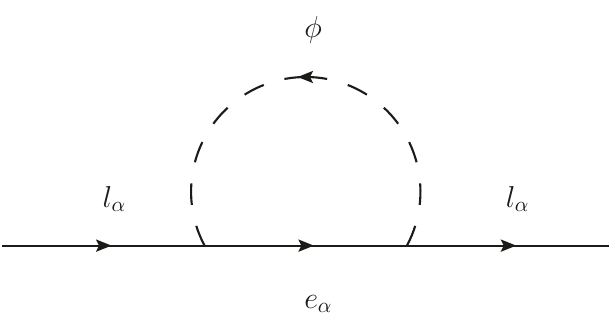
Figure 1 . The one-loop contribution to the thermal-width for left-handed leptonic doublet of (cid:13)avour (cid:11) ( l (cid:11) ) through the right-handed singlet of the same (cid:13)avour ( e (cid:11)